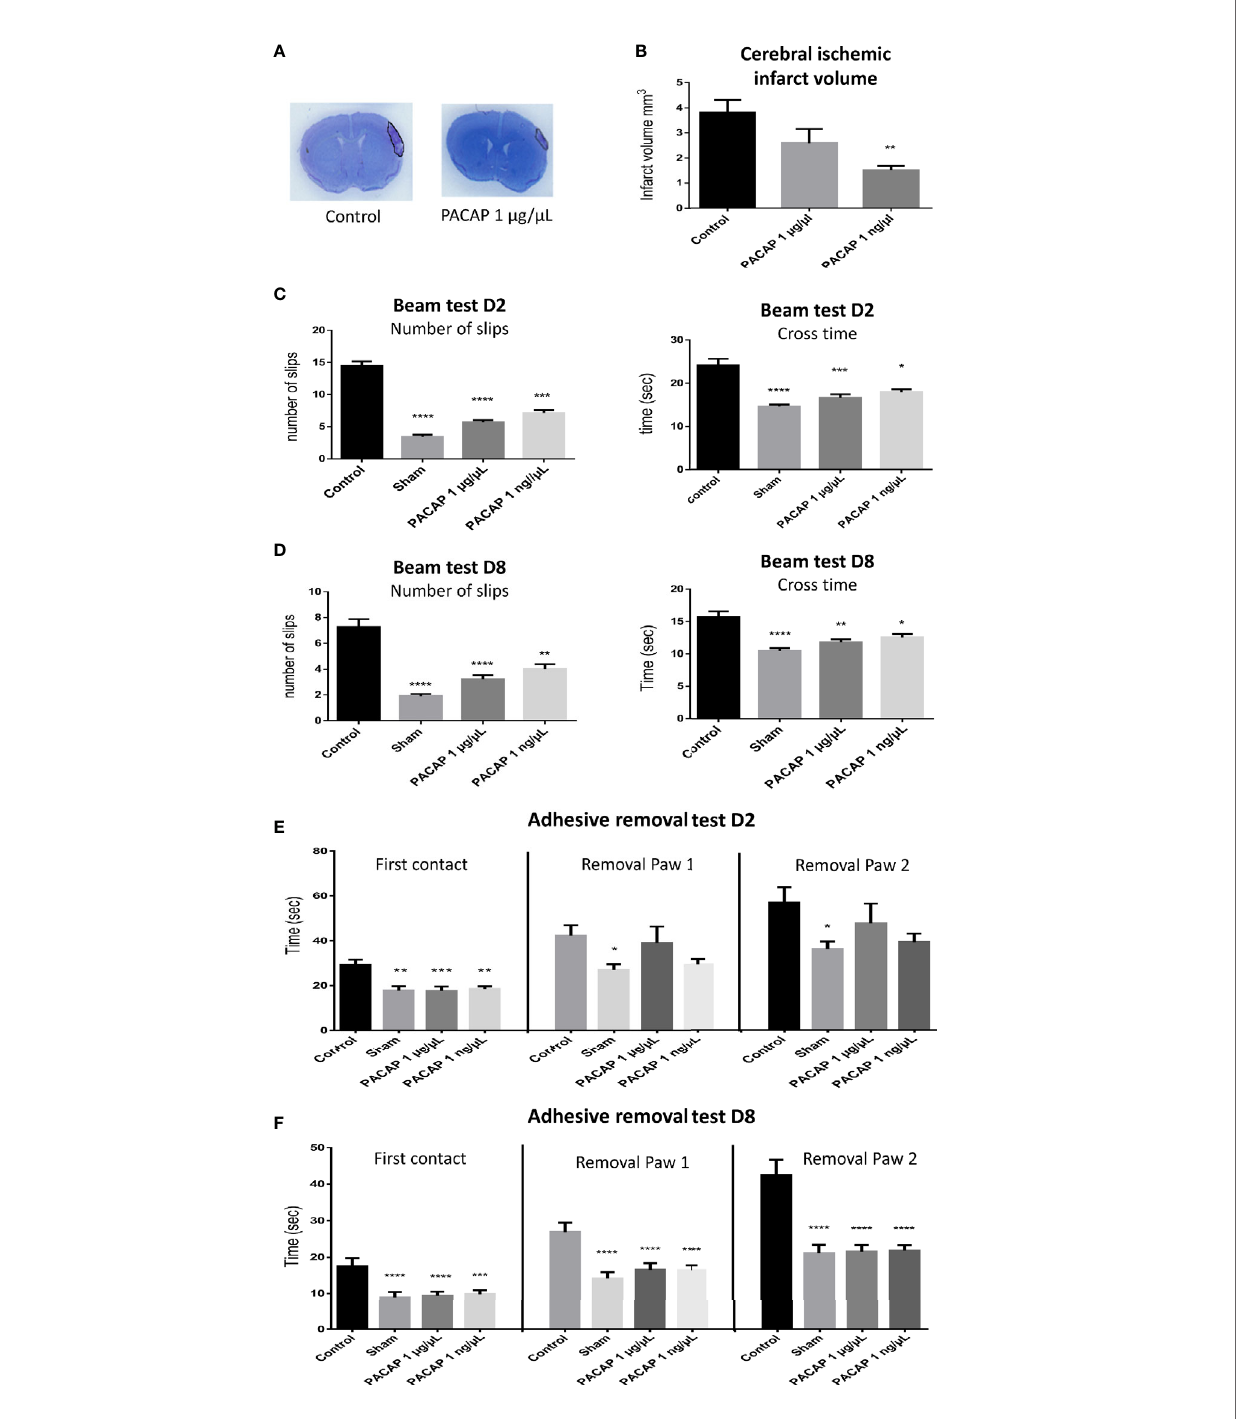
FIGURE 3 | Effects on the infarct volume and functional recovery of delayed (6 h post pMCAO) PACAP daily administration, 2 and 8 days after brain ischemia. Male C57BL6 mice were treated with a saline solution (control, sham) or with different concentrations of PACAP. (A) Illustration of the brain infarct zone after NaCl (control) or PACAP 1 µg/µl intranasal administration, 8 days after pMCAO. (B) Cerebral ischemic infarct volume (mm 3 ) 8 days after pMCAO. (C, D) Beam test indicating cross times and number of slips of mice (sham and stroked animals) on 9 mm beam 2 and 8 days after stroke. (E, F) Adhesive removal test with the time taken for fi rst contact and adhesive removal from mice paws 2 and 8 days after stroke. PACAP treatment promoted functional recovery and reduced cerebral ischemic lesions in stroke mice. Errors are reported as Mean ± S.E.M and n ≥ 8 animals per group. (*P < 0.05; **P < 0.01; ***P < 0.001, ****P <